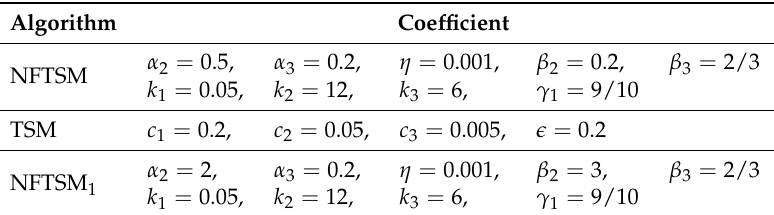
Table 2. Coefficients of the different guidance laws, TSM: terminal sliding mode, NFTSM: nonsingular fast TSM, NFTSM 1 : NFTSM with another set of